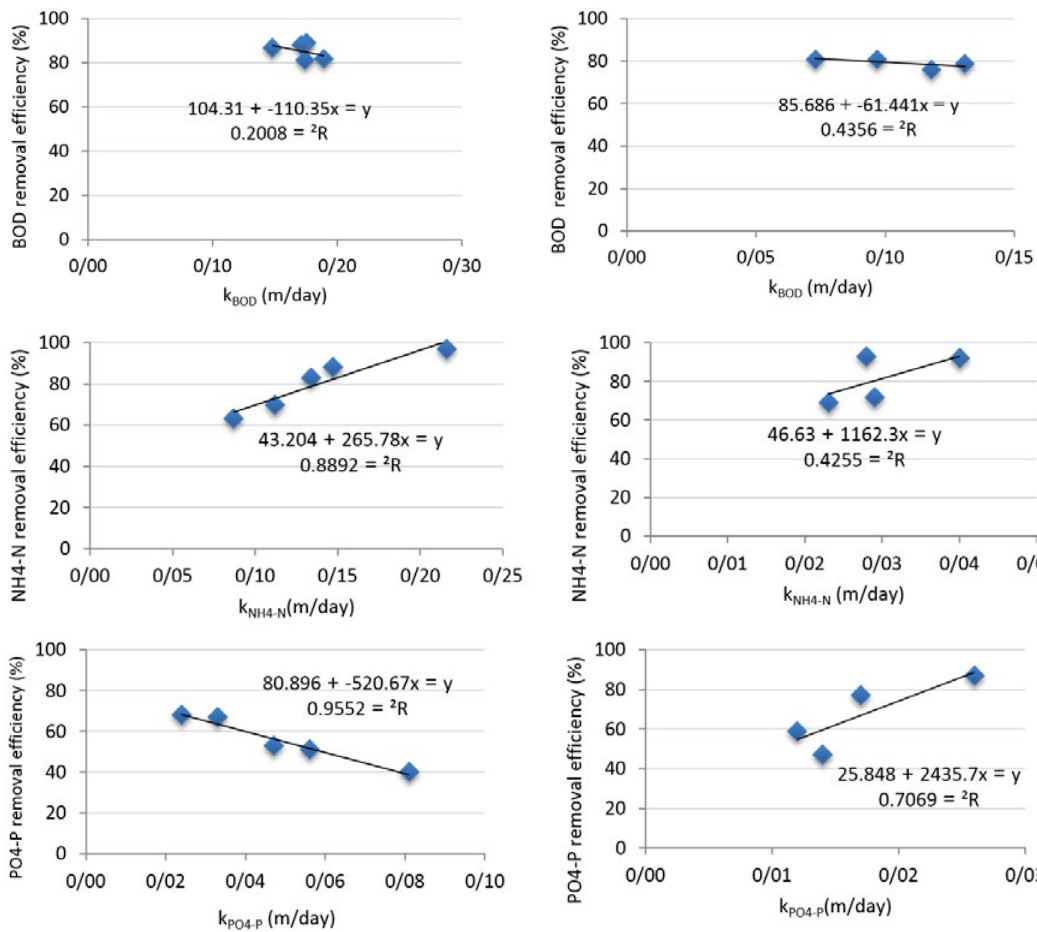
Fig. 8: Correlation between pollutant removal efficiency and removal rate constant